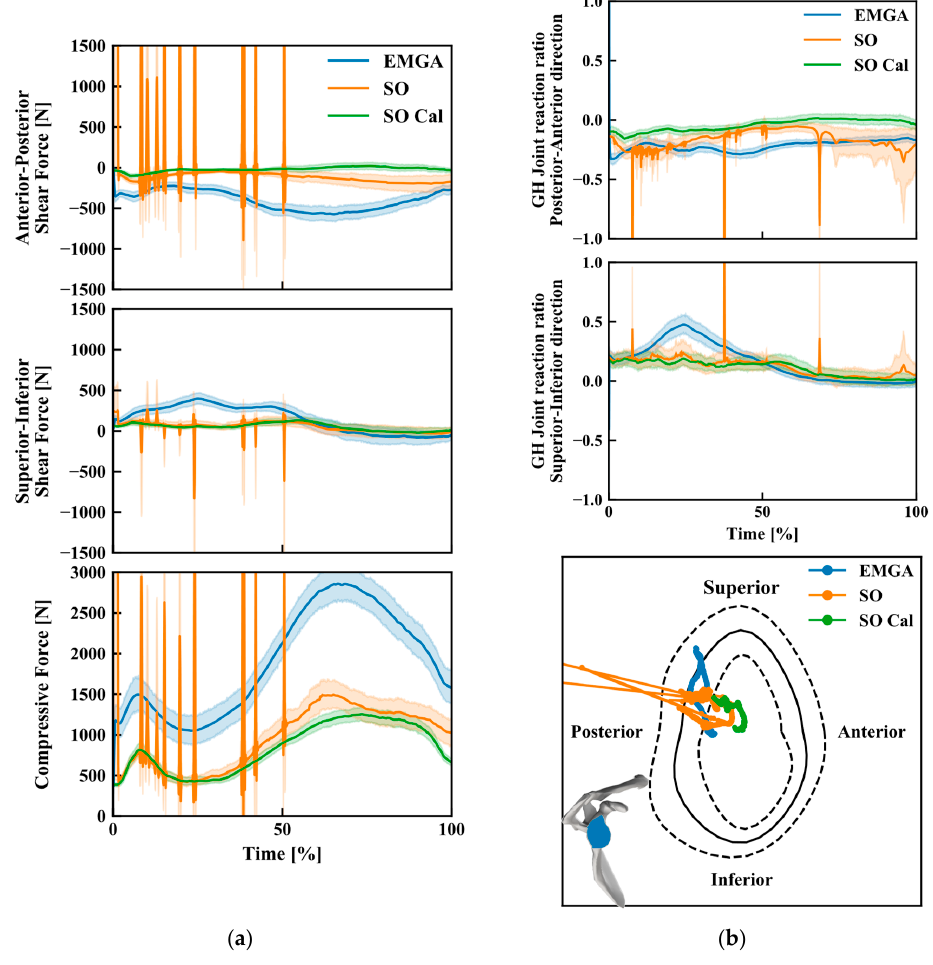
Figure 7. ( a ) GH joint reaction forces (solid line: mean value, shaded region: 95% confidence interval) calculated from the muscle activations predicted from the EMGA (blue), SO (orange) and SOcal (green); ( b ) Top: GH joint reaction shear/compressive ratio, bottom: ratio of the GH force in regard to the non-dislocation threshold ratios from Lippitt and Matsen [1] in the glenoid frame (mean ± 1 std: solid ± dashed black lines): If the GH joint reaction shear/compressive ratio is within the cone, the joint is considered as stable. The data shown are from the EMGA (blue), SO (orange) and SOcal (green, solid line: mean value, shaded region: 95% confidence interval).